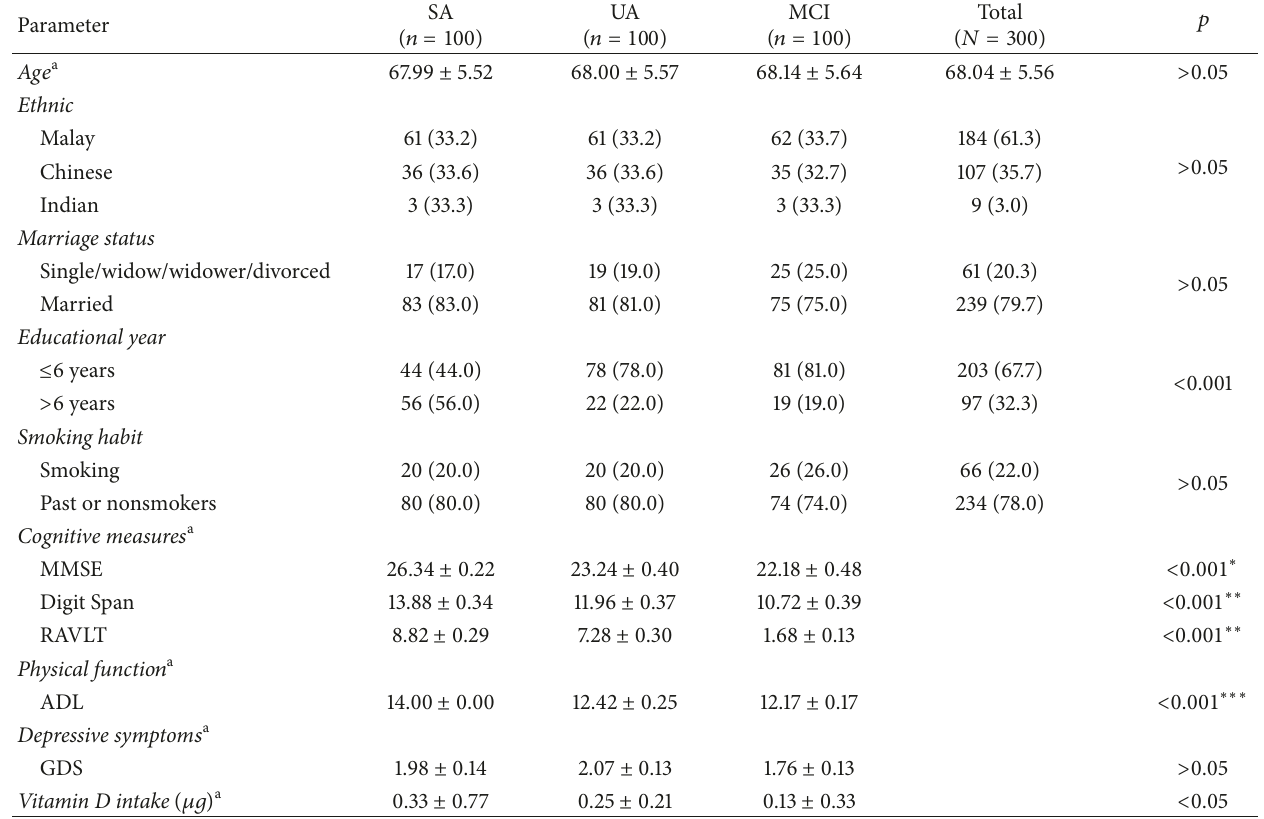
Table 2: Sociodemographic characteristics.